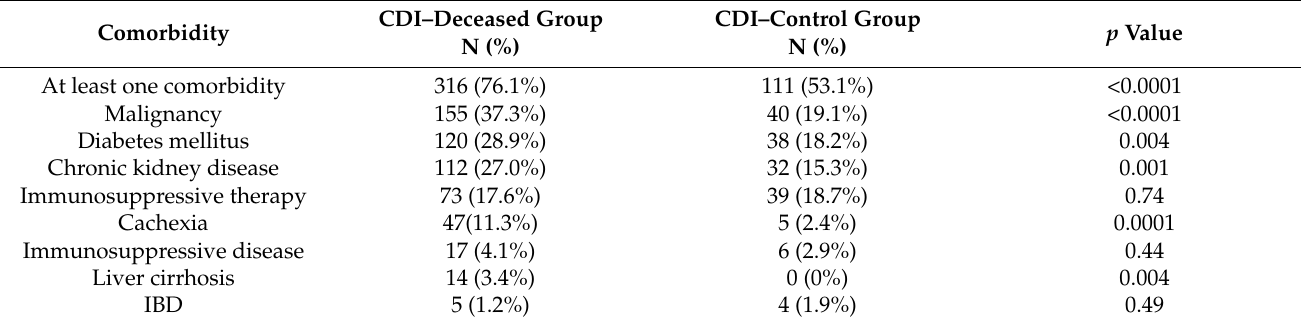
Table 3. The frequency of co-morbidities regarded as possible risk factors for CDI mortality.